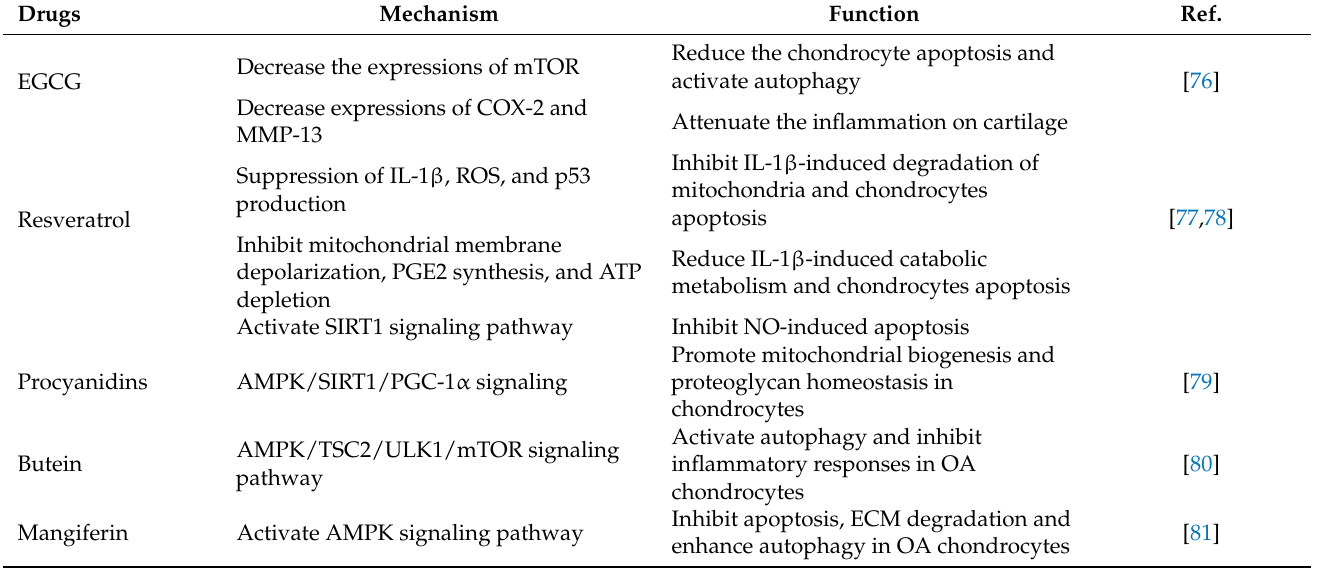
Table 2. Classifications and biological functions of polyphenol in